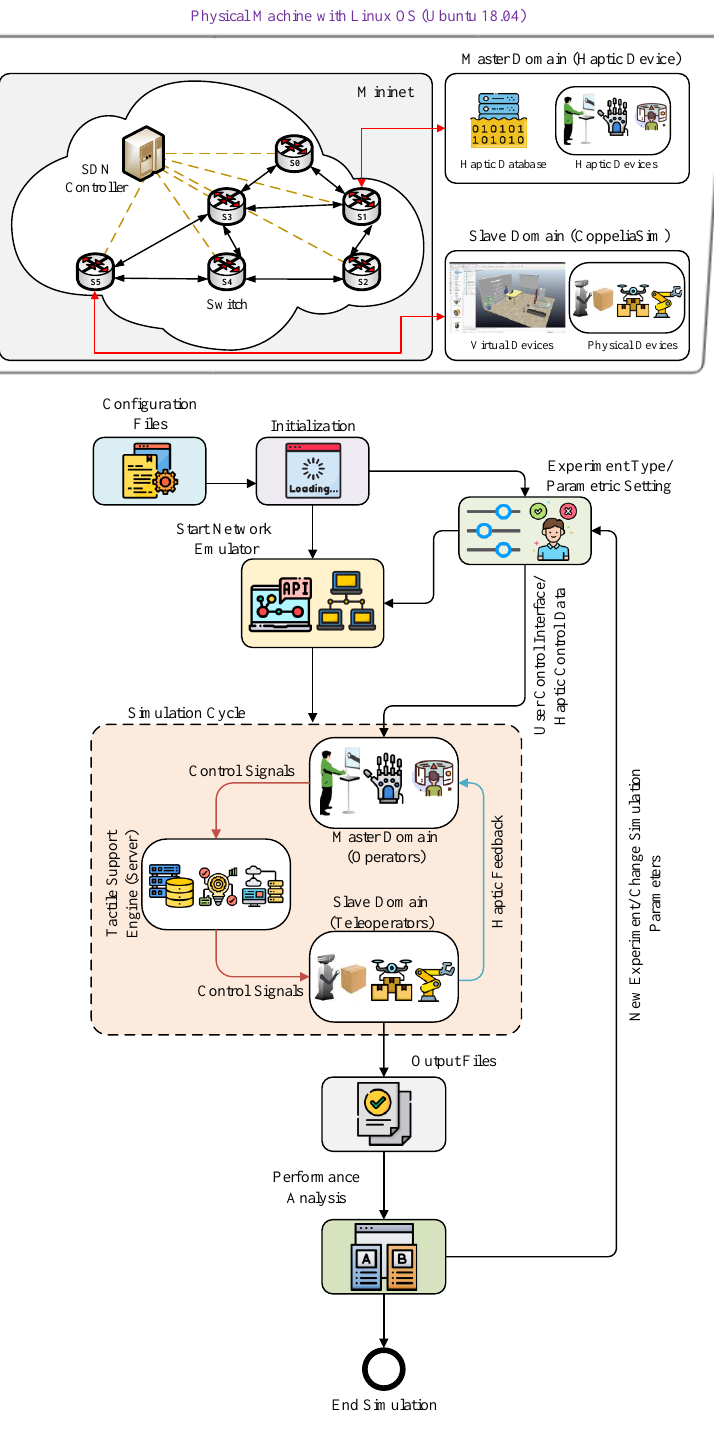
Figure 6. The flowchart illustrating the overall flow of the IoTactileSim testbed dynamics and relationship between different